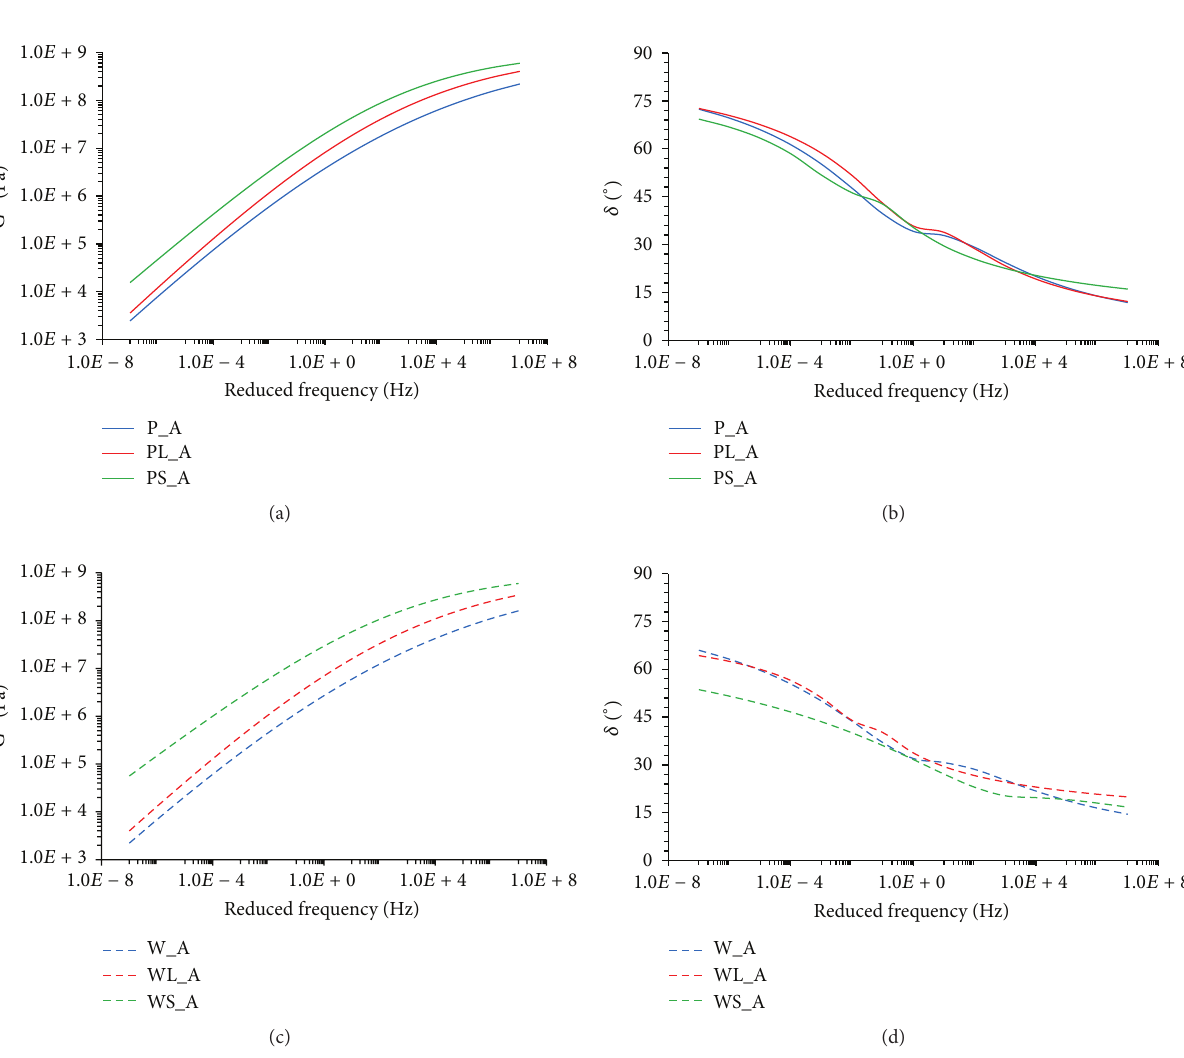
Figure 6: 𝐺 ∗ (left) and 𝛿 (right) master curves for hot (a, b) and warm (c, d) materials.